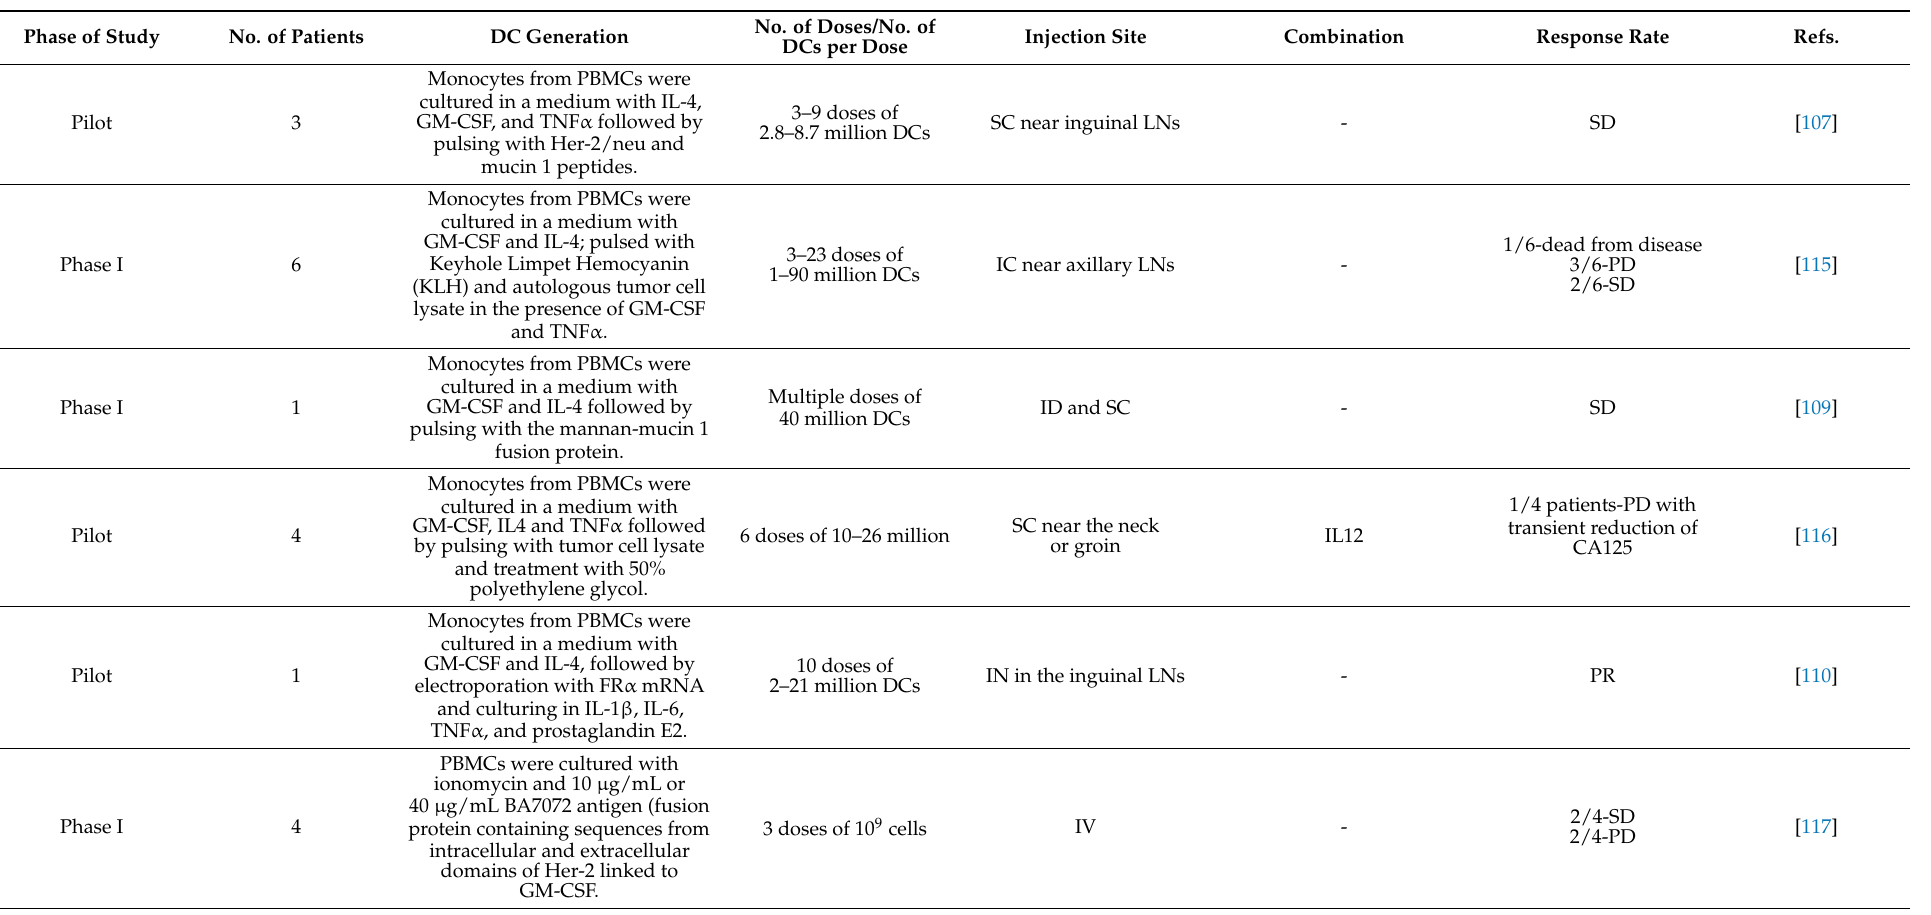
Table 2. An overview of different pilot studies and clinical trials of DC vaccination with published results carried out in OC (accessed on 15 August